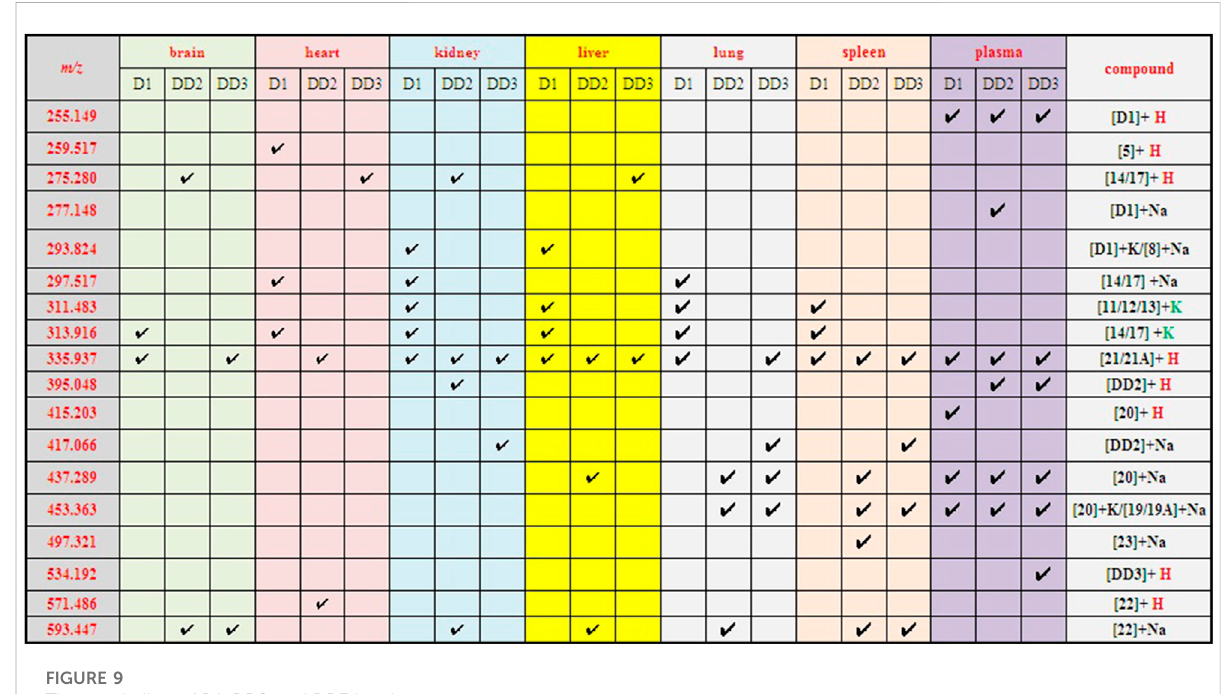
FIGURE 9 The metabolites of D1, DD2, and DD3 in